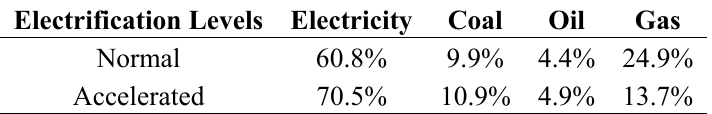
Table 9. Shares of different energy forms in commercial demand by